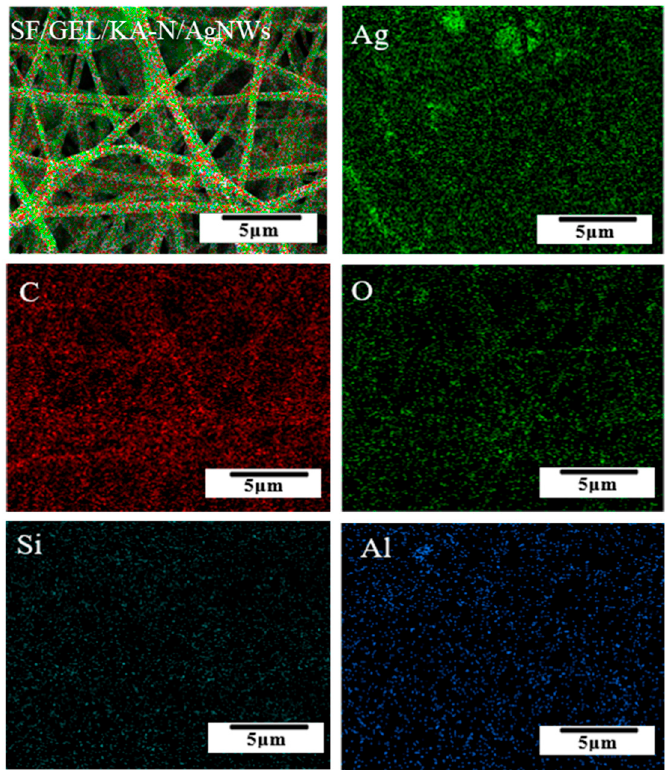
Figure 4. Elemental distribution diagram of argentum, carbon, oxygen, silicon, and aluminum in the SF/GEL/KA-N/AgNWs porous fi ber fi lm.